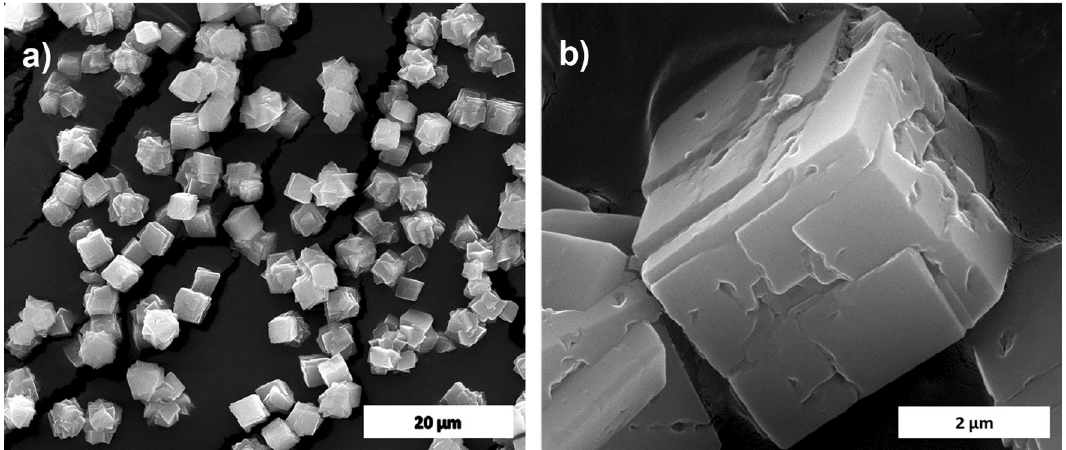
Figure 2. SEM image of calcite ( a ) and its magnified image ( b